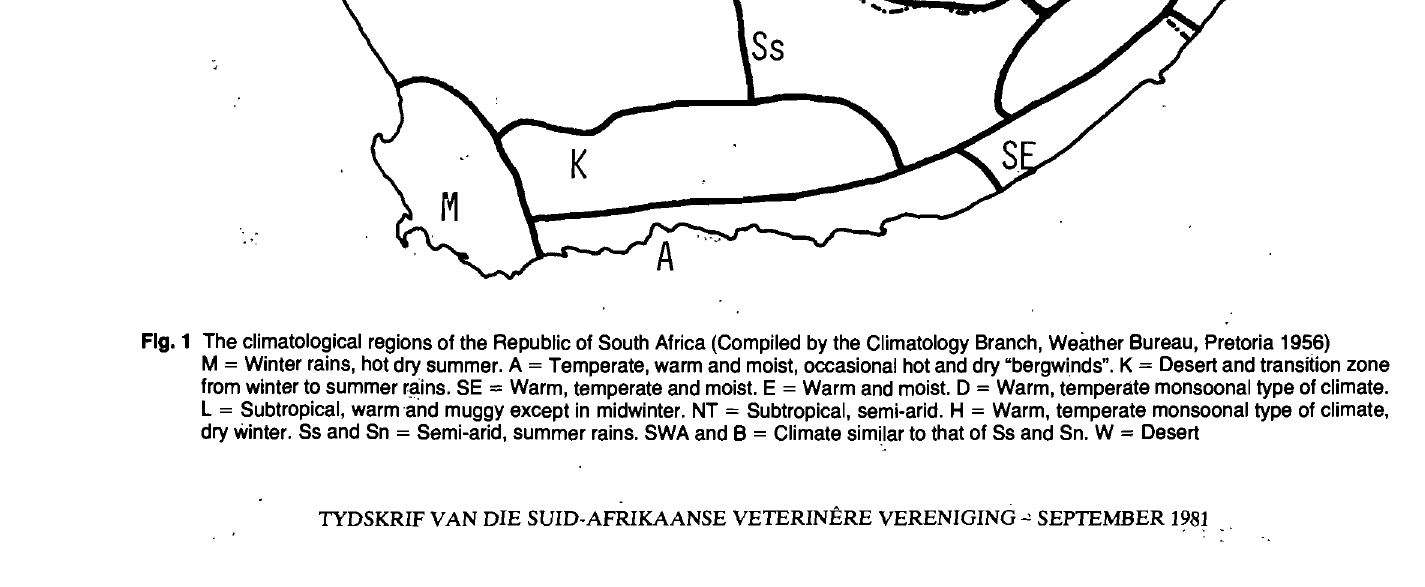
TYDSKRIF VAN DIE SUID-AFRIKAANSE VETERINERE VERENIGING -' SEPTEMBER